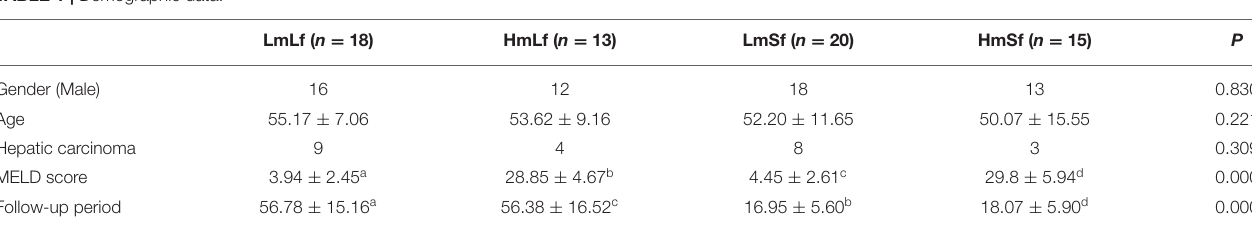
TABLE 1 | Demographic